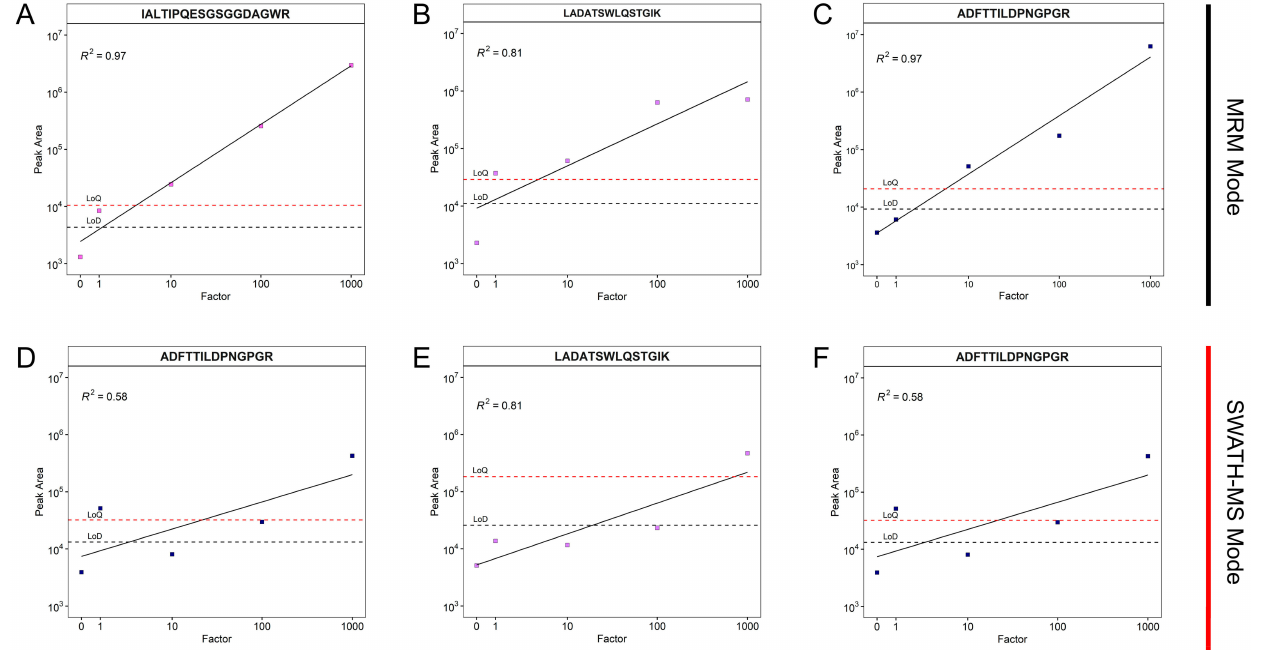
Figure 1. Correlation of MRM and SWATH-MS measurements for different dilution factors of the fungal enzyme preparation added to the biogas reactor content and incubated for 24 h. ( A – C ), correlation between the measured peak area of three selected peptides for the MRM mode; ( D – F ), SWATH-MS mode. The titles of the subplots display the peptide sequences. The correlation coefficients are shown in each